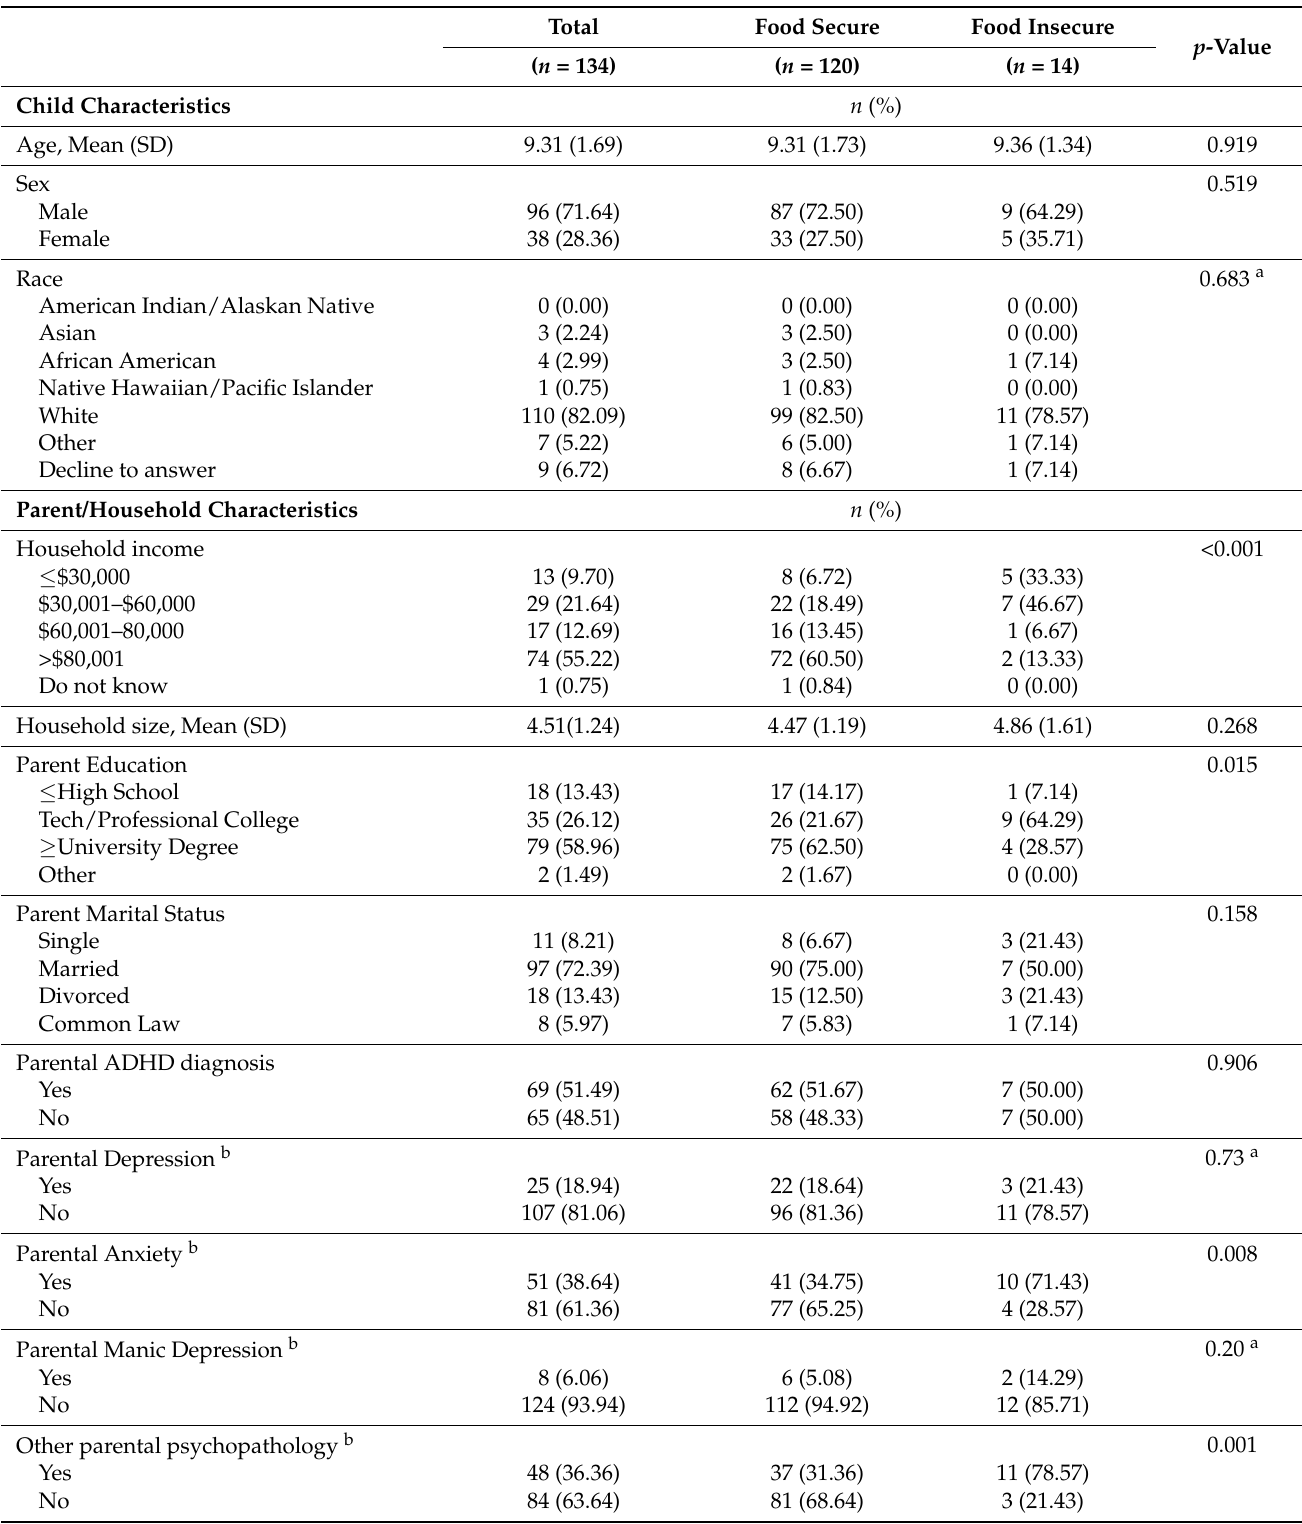
Table 1. Participant characteristics according to household food security